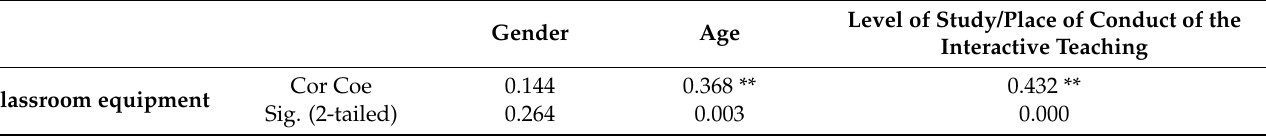
Table 13. Spearman’s rho correlation test for relation of the “classroom equipment” to the profile and demographics of the budding journalists.